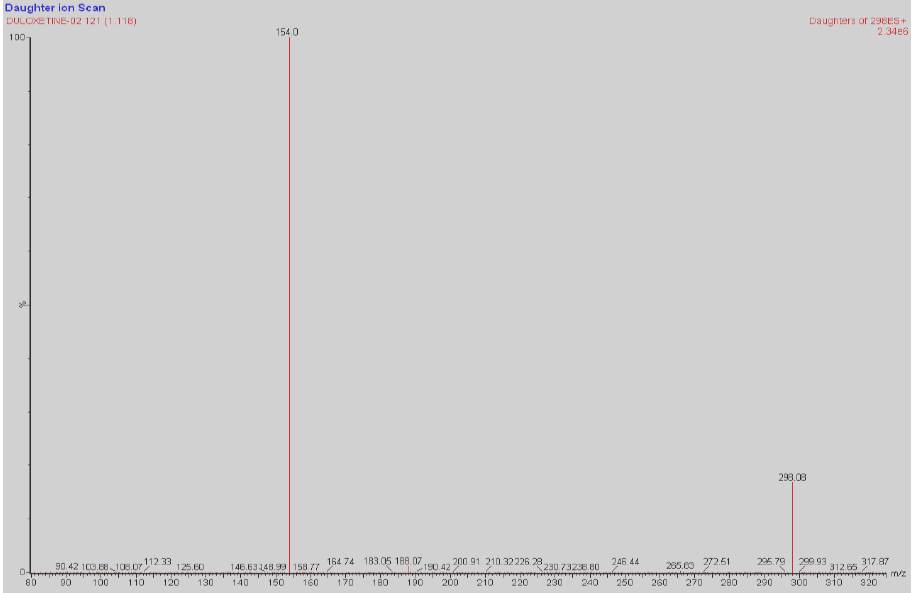
Figure 2. (A). Product ion mass spectra of Duloxetine (m/z 298.08→154.0, scan range 80-320